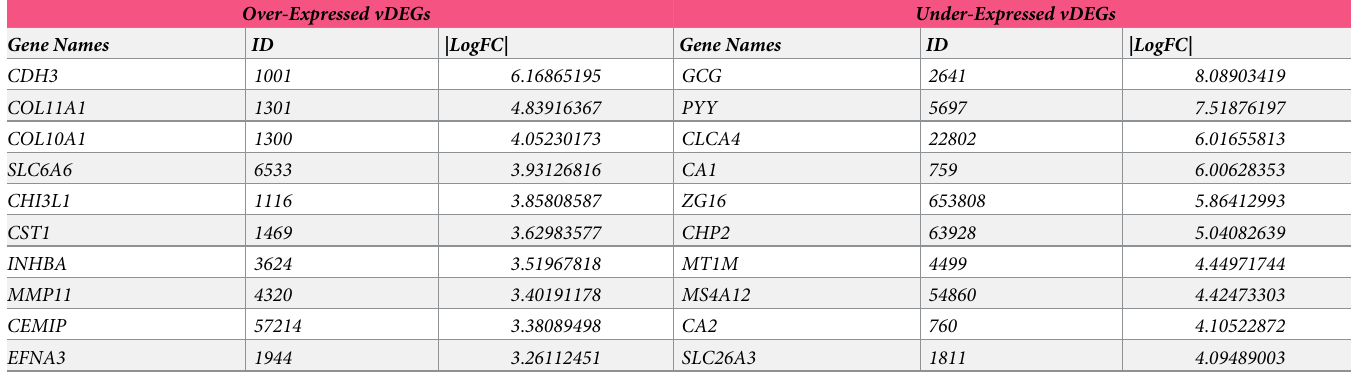
Table 1. The list of top-ten validated Differentially Expressed Genes ordered by their |LogFC| values in the discovery dataset (GSE41258). Over-Expressed